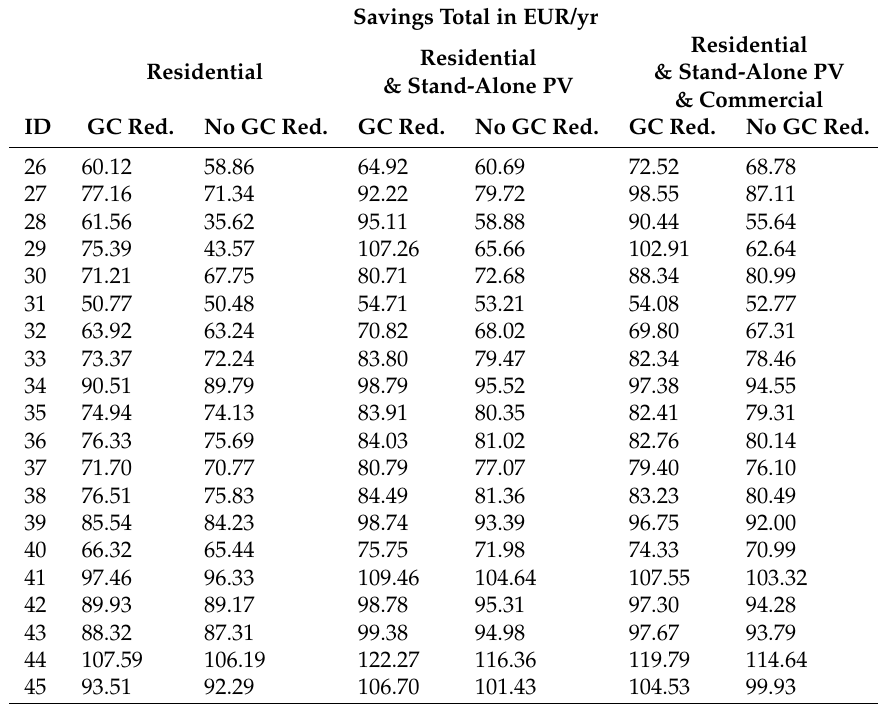
Table 14. Comparison of savings for customers 26–45, with and without reduction of grid